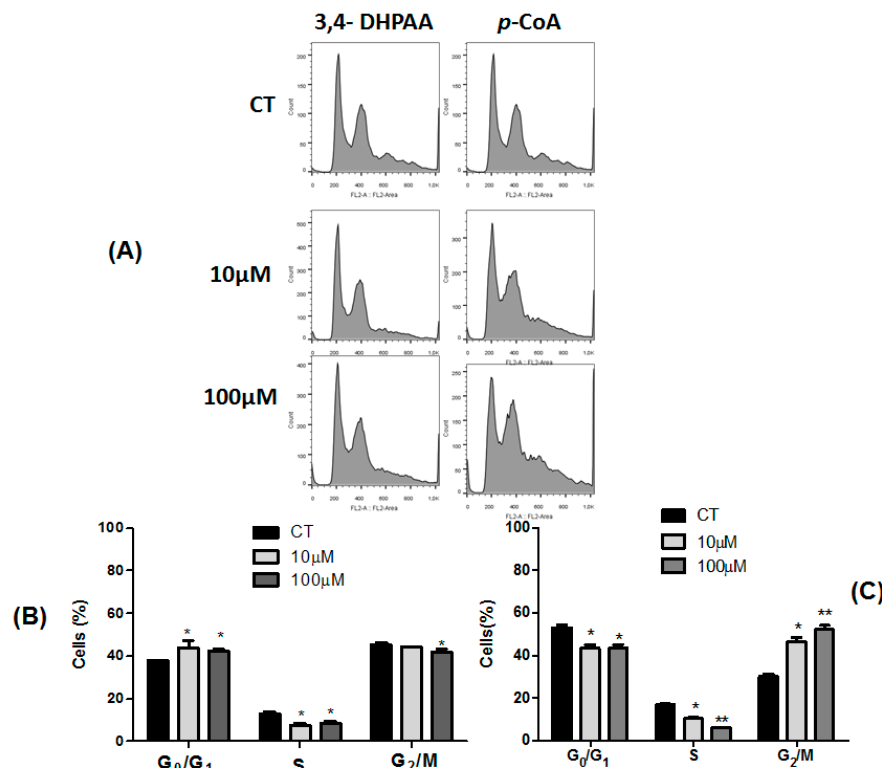
Figure 3. Effect of 3,4-DHPAA and p -CoA on cell cycle progression in HT-29 cells 24 h after incubation. The phases of the cell cycle are illustrated at control (CT) and treated with 10.0 µM and 100.0 µM of these compounds in figure ( A ). The quantitative results of the effect of 3,4-DHPAA compound on this cell line are shown in figure ( B ) and p -CoA in figure ( C ). The experiment is expressed as mean ± SD. Significant differences between untreated and treated (10 µM and 100 µM) cells were compared by the One-way ANOVA test, with Tukey posttest (* p < 0.05; ** p < 0.01).